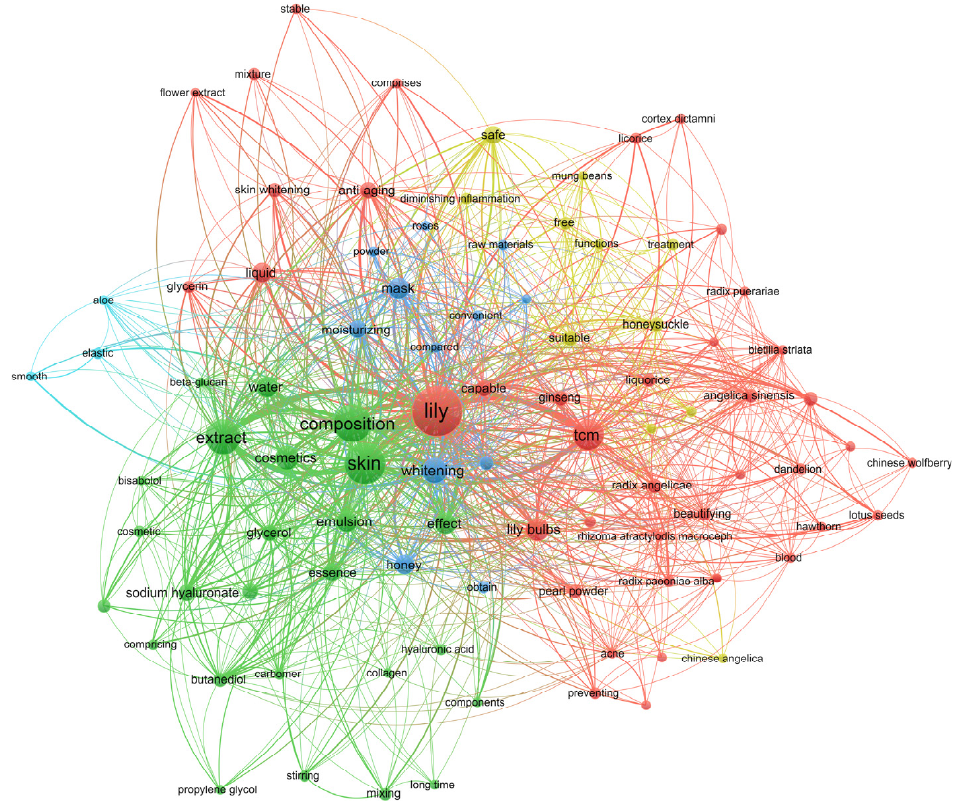
Figure 4. Keyword co-occurrence analysis of lily-related patents. Note: tcm indicates traditional Chinese medicine composition.